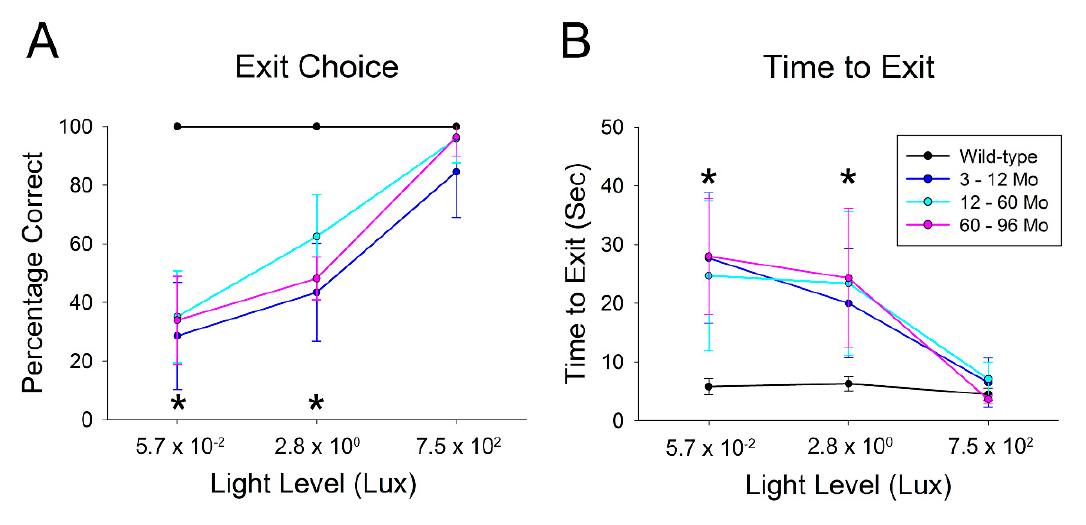
Figure 2. Vision testing results in Rpe65-deficient dogs. ( A ). The mean correct exit choices ( ± SD) for the wild-type and three age groups of Rpe65-deficient dogs. At full room light (~750 lux), there was no significant difference in correct exit choices. For the intermediate and low light levels (~2.8 and ~0.057 lux), the Rpe65-deficient dogs made significantly more errors in tunnel choice than the control dogs. There were no significant differences in correct exit choices between the three age groups of Rpe65-deficient dogs at any of the light intensities. ( B ). The mean time to exit the vision testing apparatus ( ± SD). The Rpe65-deficient dogs in all age groups exited the device rapidly and in a similar time to the control dogs. At the lower two lighting levels, they took significantly longer to exit the device than the wild-type controls. There were no significant differences in time to exit between any of the three age groups of Rpe65-deficient dogs at any light intensity. Dogs are grouped as follows: wild-type dogs 6–14 months, n = 10 eyes; Rpe65-deficient dogs 3–12 months, n = 24 eyes; 12–60 months, n = 24 eyes, and 60–96 months, n = 8 eyes. * p < 0.05.